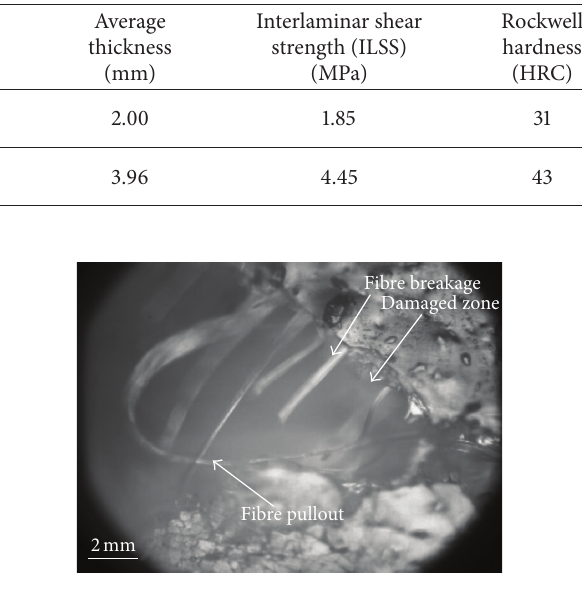
Figure 18: The deformed surface of the interwoven hybrid compos- ite shows fibre pullout after the interlaminar shear test.